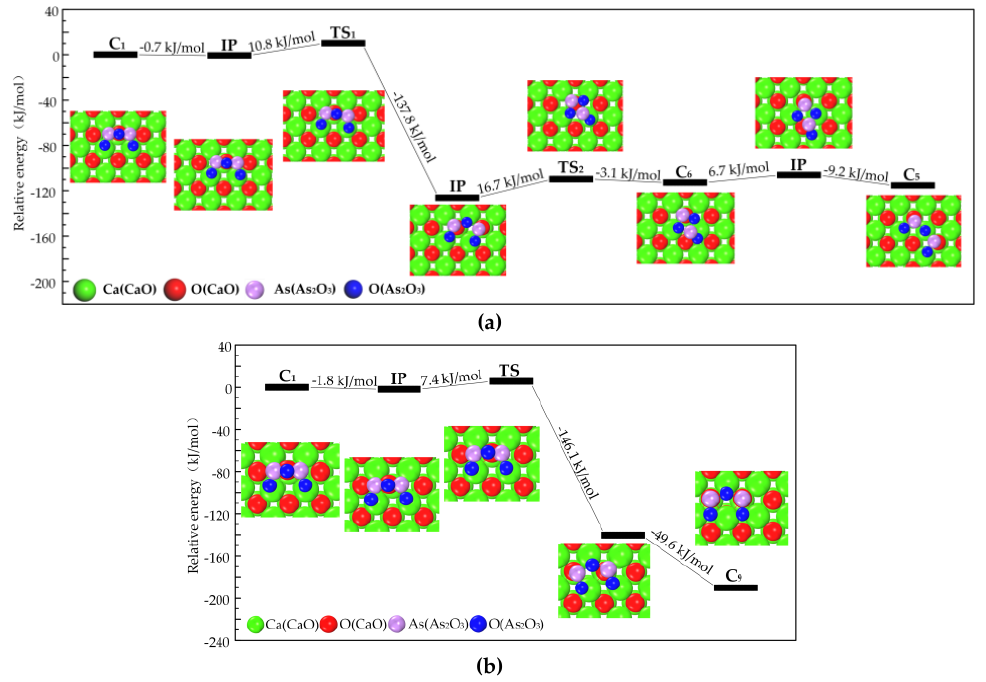
Figure 2. Transformation path of Category I. ( a ) Category I to Category II and III; ( b ) Category I to Category IV.